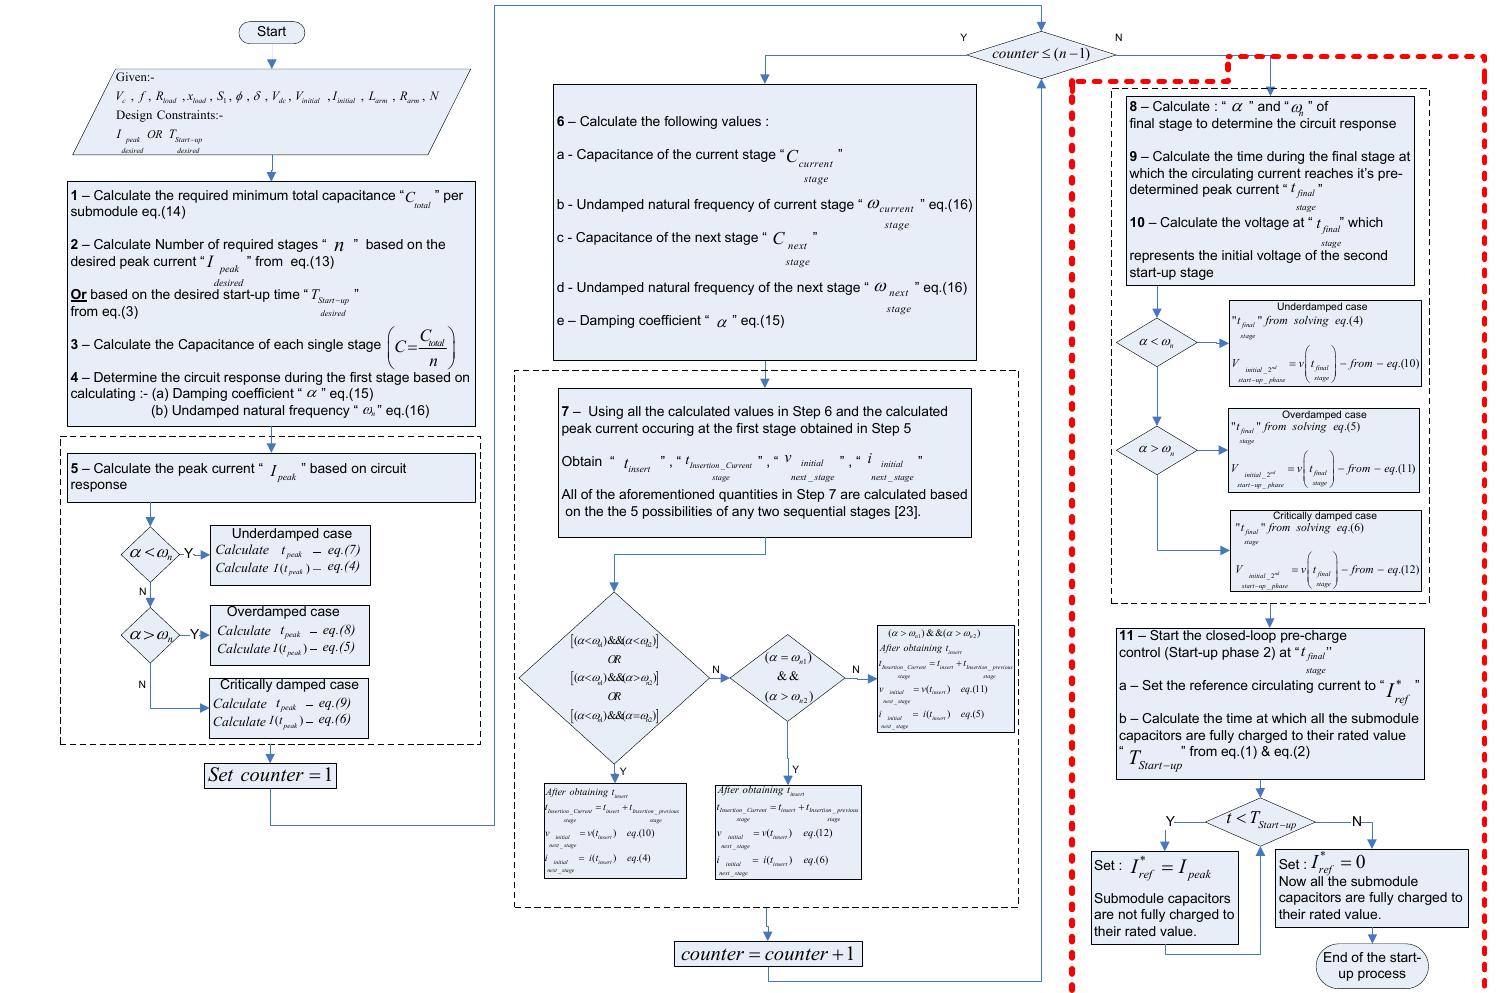
Figure 2. The flowchart of the proposed start-up method for the single-phase MMC. * t insert was obtained using the algorithm in [26]. ** Step 8 till the end of the flowchart represents the proposed strategy in this article for combining the sequential capacitors’ charging methods during the uncontrolled start-up phase [26] and the closed-loop precharging control during the controllable start-up phase